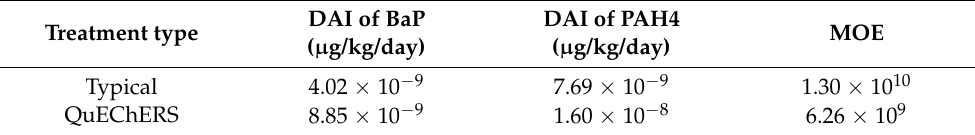
Table 7. Average DAI and MOE values in herbal medicine